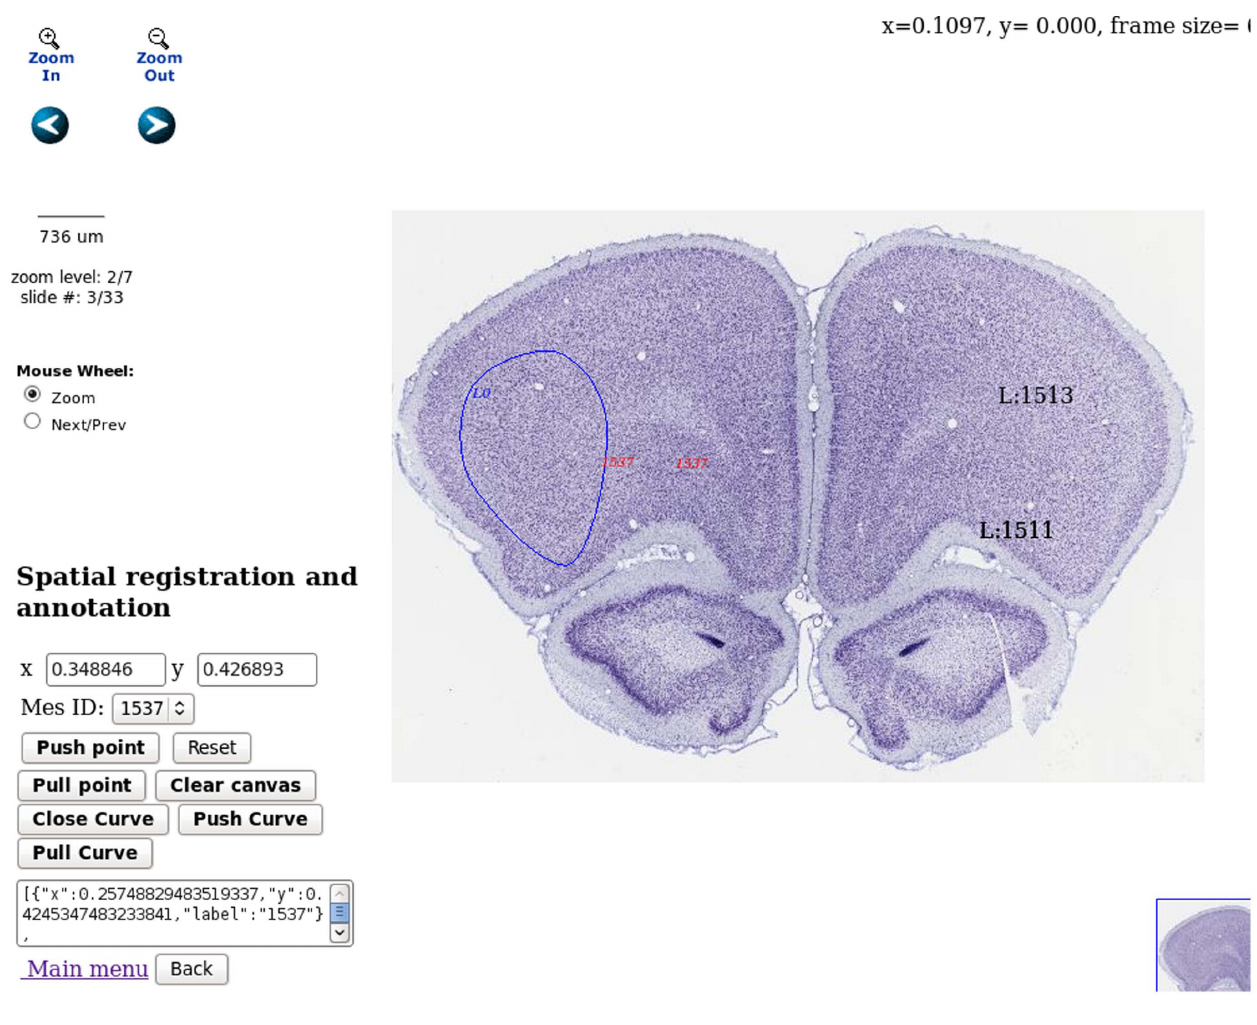
demonstrated provisional annotations produced by mouse clicks on the client side. In black are demonstrated measurements, already stored on the server. Spatial annotation storage and retrieval can be done using the user interface in the bottom left part of the web page. Spatial navigation in the atlas dataset can be done using the icons in the top left part of the web